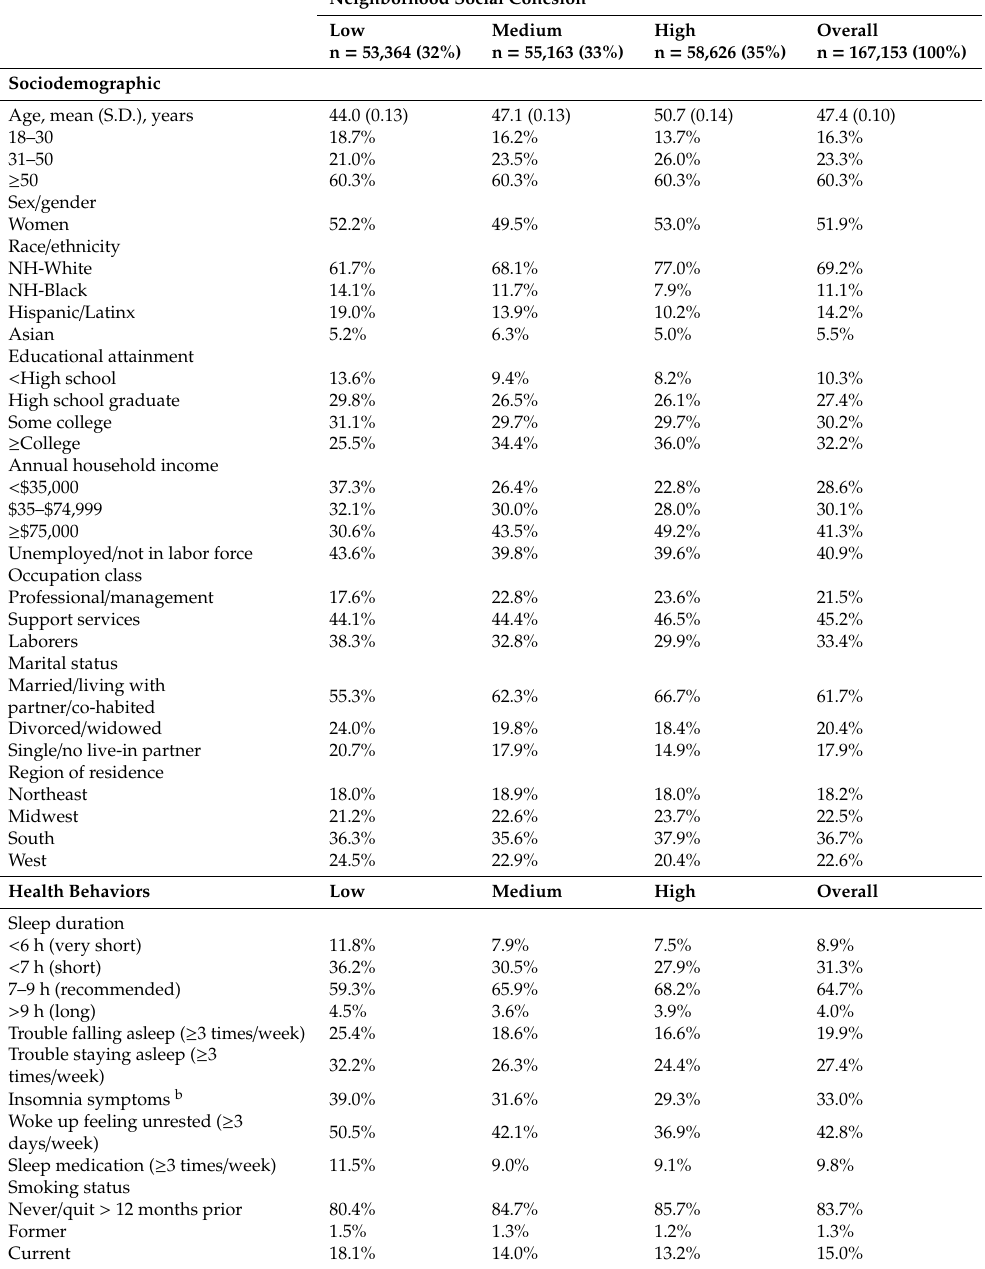
Table 1. Age-standardized sociodemographic, health behavior, and clinical characteristics between low, medium, and high neighborhood social cohesion, taken from the National Health Interview Survey, 2013–2018 (n = 167,153) a